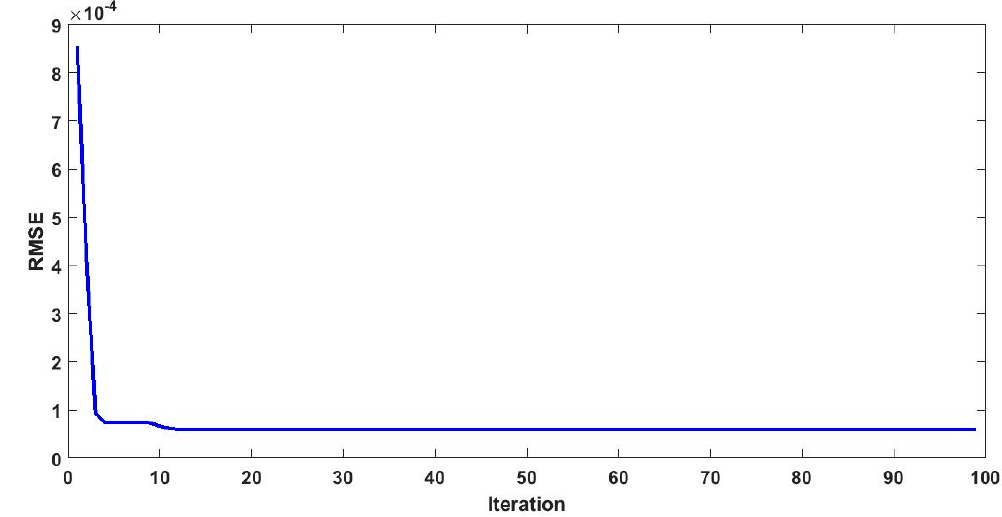
Figure 4. Convergence rate of the MTDM using CLPSO.